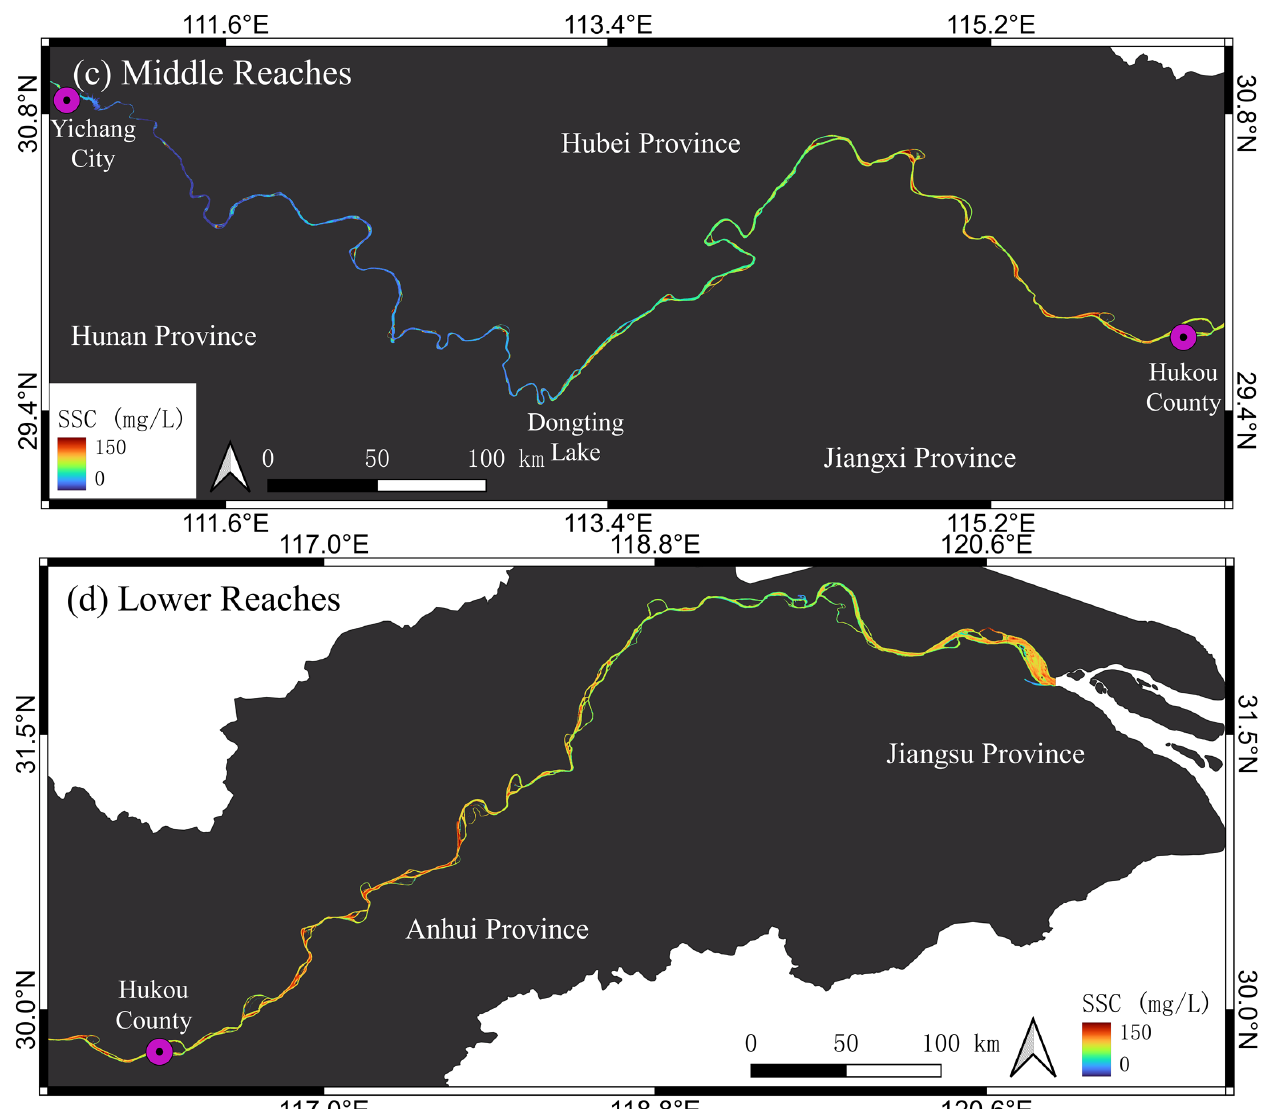
Figure 9. Spatial distributions of the median SSC from 2017 to 2021; ( a ) whole Yangtze River; ( b ) upper reaches; ( c ) middle reaches; and ( d ) lower reaches. Yichang is the dividing point between upstream and midstream, while Hukou is the dividing point between midstream and down- stream.